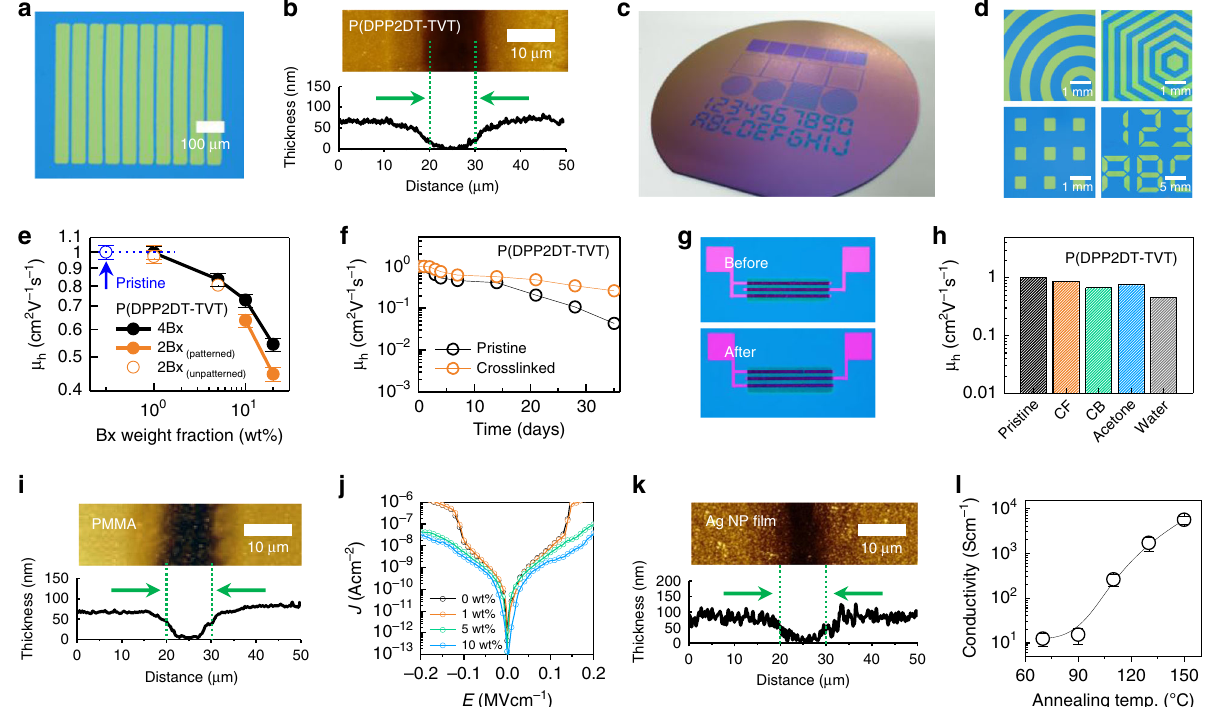
Fig. 3 Characterization of electronic components photopatterned using 4Bx. a OM image of photopatterned P(DPP2DT-TVT) fi lms with a spacing of 10